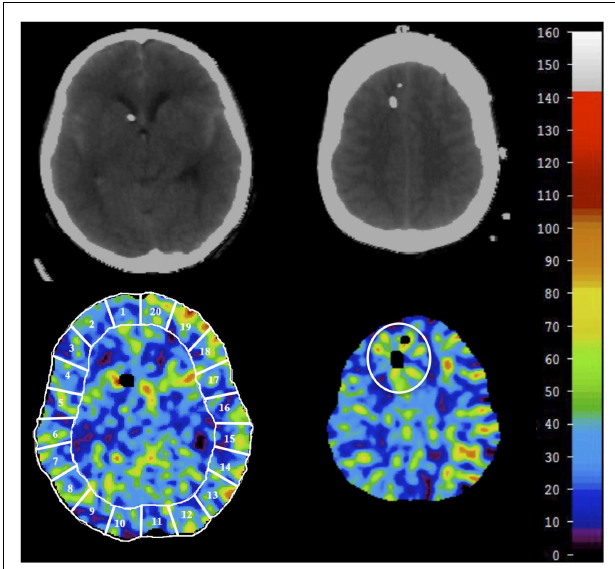
FIGURE 1 |At each level, CBF in 20 ROIs was calculated and averaged for global CBF (lower left) .The vascular territories were analyzed as follows: anterior cerebral artery ROI 1–2 (lower right) and 19–20 (lower left), middle cerebral artery ROI 3–8 (lower right) and 13–18 (lower left), and posterior cerebral artery ROI 9–10 (lower right) and 11–12 (lower left). For CBF around the microdialysis catheter, a ROI was manually drawn around the microdialysis catheter after localization on CT-scan (lower right).